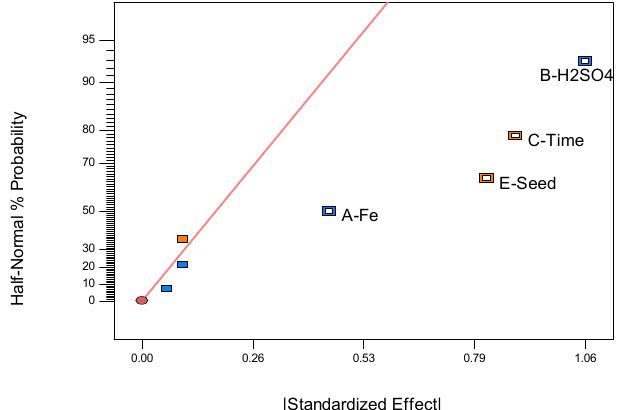
Figure 1. Half-normal probability plot for the factors and their interactions for log (%Fe(III) precipitated).